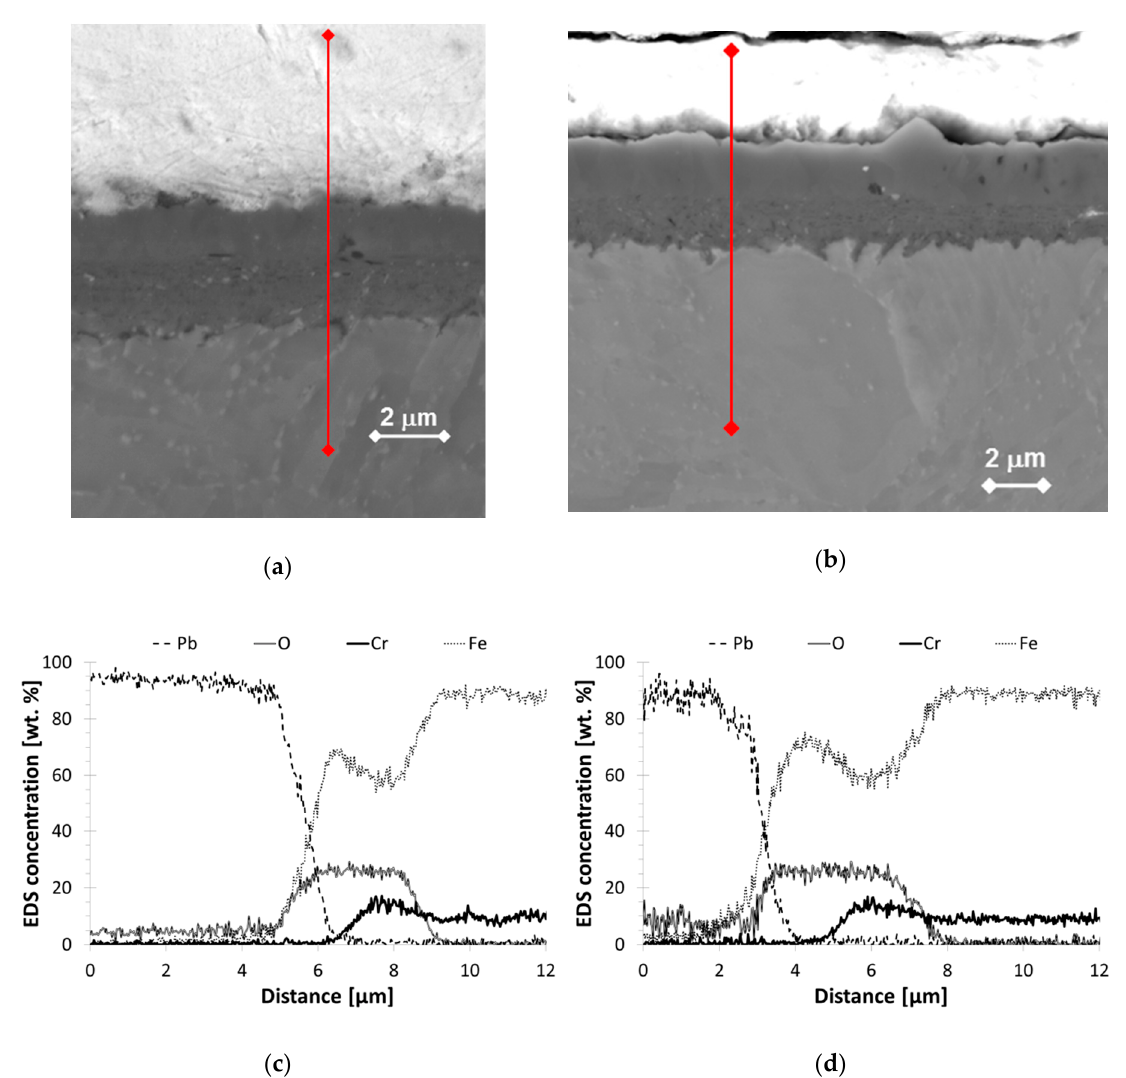
Figure 4. Bend specimens’ exposure to liquid Pb: ( a ) Oxide scale in the site not affected by stress (T110); ( b ) Oxide scale exposed to the stress (100%YS, T100) with red lines marking the position of EDS line scan. ( c ) EDS line scan corresponding to (a) and ( d ) EDS line scan of